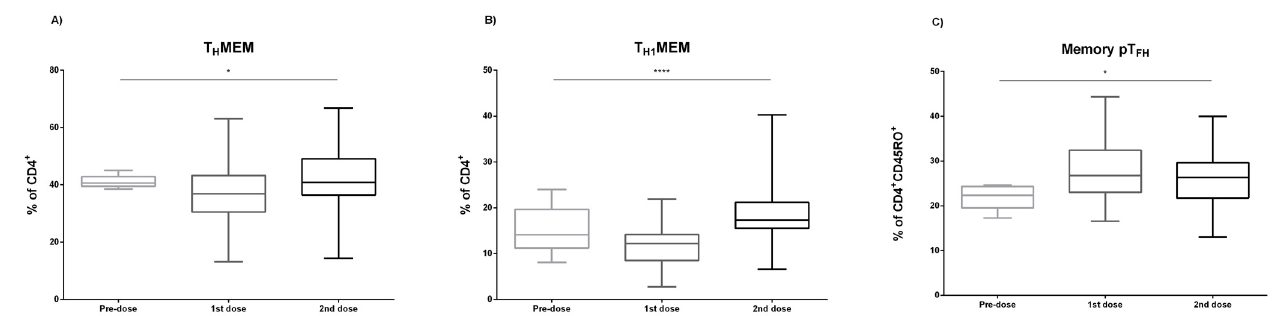
Figure 3. T-specific SARS-CoV-2 vaccine assessment. The frequency of memory T helper (T H MEM) ( A ), memory T helper 1 (T H1 MEM) ( B ), and memory peripheral T Follicular helper (pT FH ) ( C ), prior immunization (Pre-dose) after the first and the second doses (1st and 2nd dose, respectively) are depicted. Kruskal–Wallis test was used to compare medians in ( A – C ) * ( p < 0.05) and **** ( p < 0.0001).